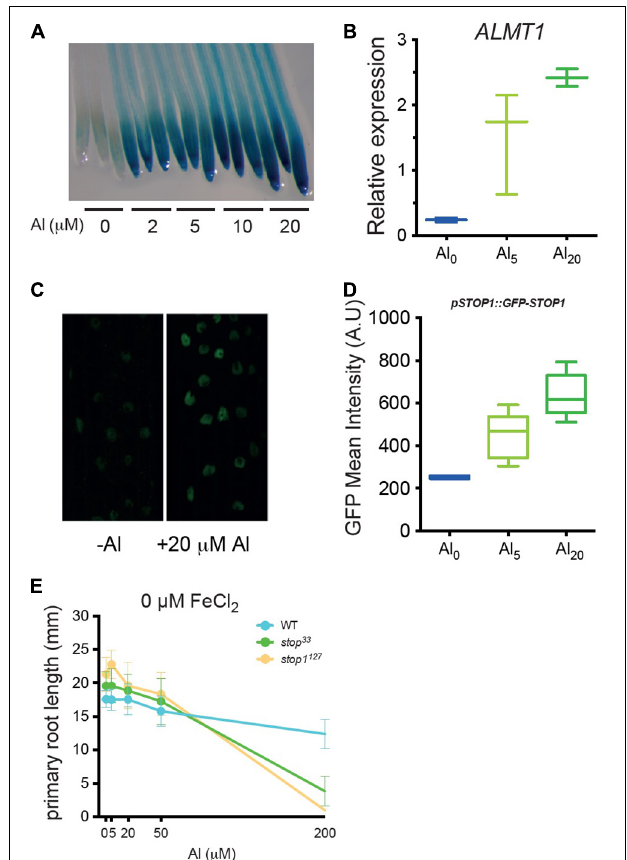
FIGURE 2 | Low concentrations of AlCl 3 at pH5.7 are sufficient to induce ALMT1 through the accumulation of STOP1 in root nuclei. (A) Dose-response of AlCl 3 on ALMT1 expression. Four day-old WT seedlings (carrying the pALMT1:GUS reporter) were grown on phosphate-rich medium and transferred on the indicated P 10 Fe 0 , pH 5.7 medium supplemented with the indicated concentrations of AlCl 3 . After 3 days a GUS staining was performed on roots for 1 h. Three representative root tips are shown per condition (see Supplementary Figure 1A for a stop1 127 null mutant grown in the same conditions). (B) Relative expression (RT-PCR) of ALMT1 in presence of 5 and 20 µ M AlCl 3 at pH 5.7 in 10 days old roots (see section “Materials and Methods). n = 3 experiments, here one of the three independent experiments is shown. (C) Representative confocal pictures ( × 40) of 5 days old pSTOP1:GFP-STOP1 seedlings were grown on P 500 Fe 10 pH5.7 medium and transferred 4 h on the indicated medium pH5.7. (D) Measurement of green fluorescent protein (GFP) fluorescence (A.U.) (see section “Materials and Methods) on the indicated medium. The multiple comparisons,